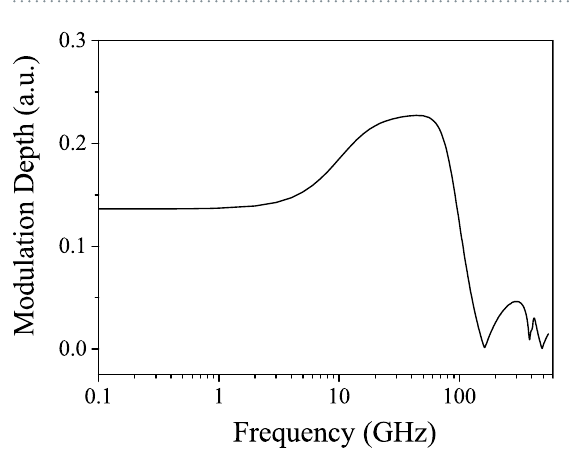
Figure 3. Modulated output signals of the resonator. The modulation frequencies are 20 GHz and 80 GHz. Here, the peak-to-peak voltage of the driving voltage is 2.0 V. The modulator is biased to set the output signals center at 0.5 along the longitudinal coordinate.